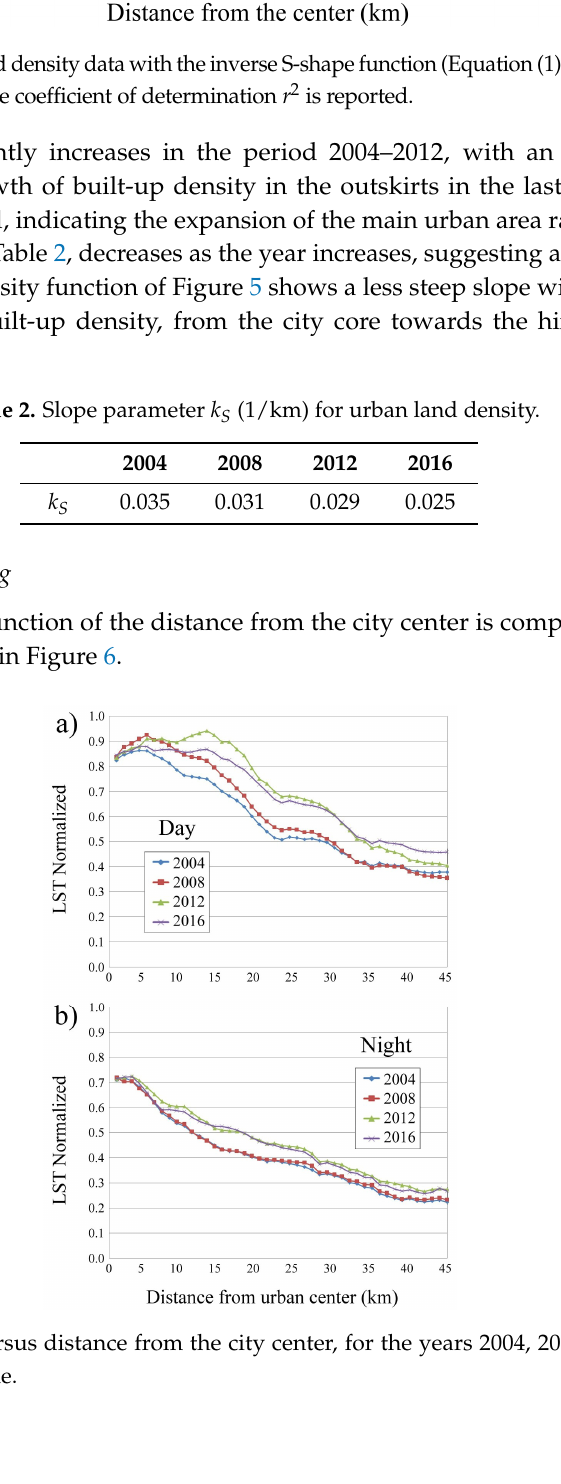
Figure 6. Mean LST n versus distance from the city center, for the years 2004, 2008, 2012, and 2016: ( a ) daytime; ( b ) night-time.